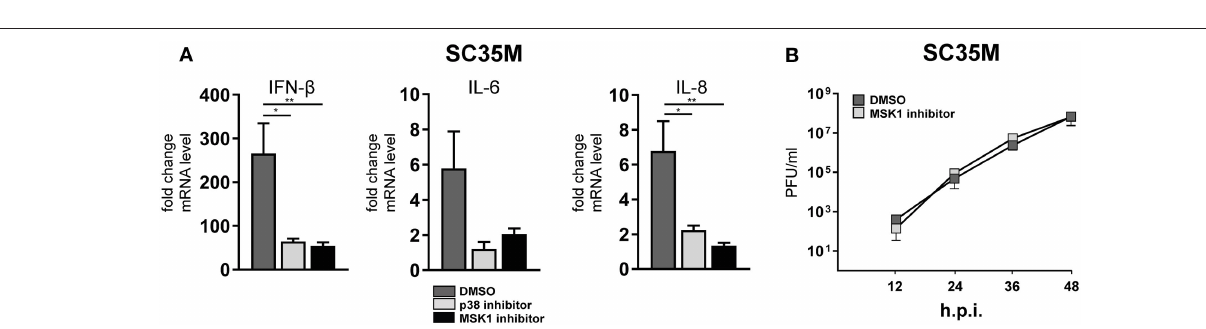
FIGURE 7 | Inhibition of p38 and MSK1 downregulates IFN- β , IL-6 and IL-8 expression. (A) A549 cells were pre-treated with inhibitors for p38 (SB202190) and MSK1 (SB747651) and infected with SC35M at an MOI of 0.1 for 24h in the presence of the inhibitors. IFN- β , IL-6 and IL-8 mRNA levels were determined by qRT-PCR. Results are depicted as mean n -fold change ( ± SEM) over non-infected cells. * p ≤ 0.03; ** p ≤ 0.0021 one-way ANOVA; Dunnett’s multiple comparisons test. (B) A549 cells were pre-treated with the MSK1 inhibitor SB747651 for 1h and subsequently infected with SC35M at an MOI of 0.001. Supernatants were analyzed at the indicated time points by plaque